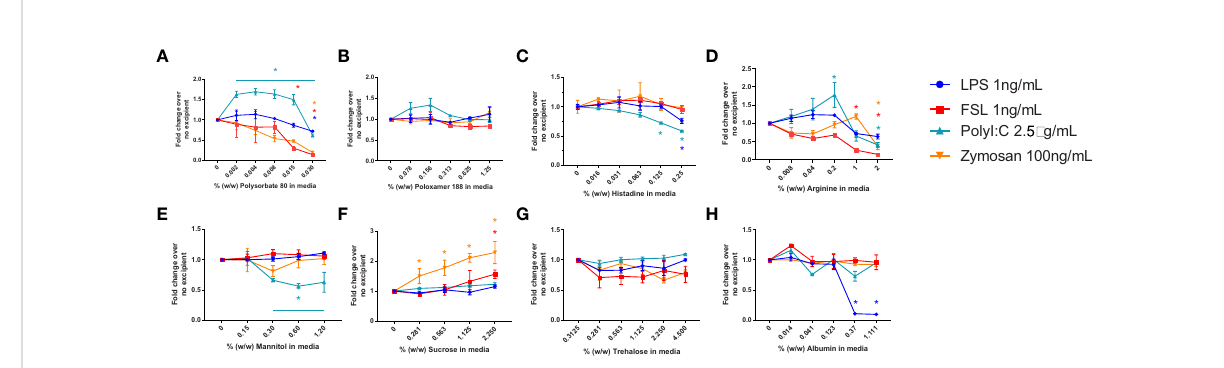
FIGURE 3 Impact of excipients on the sensitivity of THP-1-Blue cells to detect IIRMI. THP-1-Blue cells were stimulated with a single dose of model IIRMI in the presence of increasing concentration of (A) Polysorbate 80, (B) Poloxamer 188, (C) Arginine, (D) Histidine, (E) Mannitol, (F) Sucrose, (G) Trehalose, or (H) Albumin for 24 hours. IIRMI activation of THP-1-Blue cells was measured as NF- k B activation using Quanti-blue detection media. Graphs show fold changes relative to cells stimulated in the absence of excipients. Cells were treated in triplicate and results are presented as the mean ± SD of 3 independent experiments. *p <